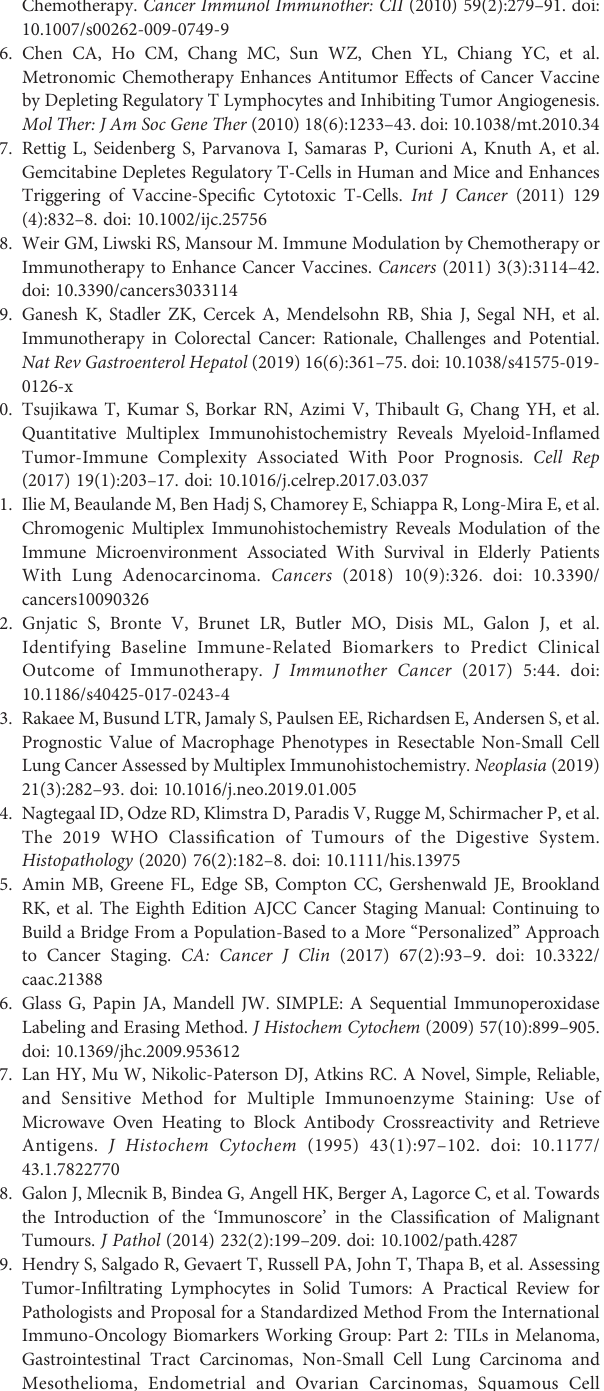
Granulocytes (F) in CT and IM region. The thick dashed lines and thin dotted lines denote the median and interquartile range, respectively. Statistical signi fi cances were determined via Wilcoxon matched-pairs signed rank test, with * P < 0.05, *** P < 0.001, n.s. not signi fi cant. Supplementary Figure S6 | Spatial distribution of B-cell and myeloid cells between non-NCT group and NCT group. Representative mIHC images showing